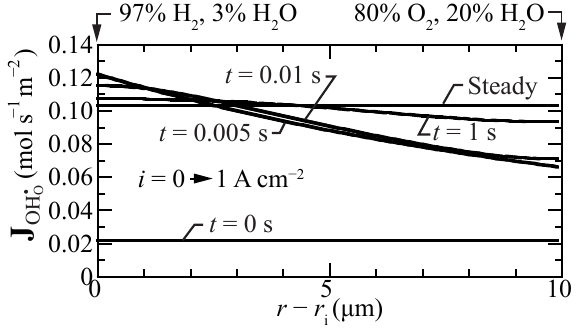
Figure 6. Transient proton-flux profiles within the membrane, beginning at open circuit mode and suddenly imposing a fuel-cell current density i = 1 A cm − 2 . The cell temperature is fixed at 600 ◦